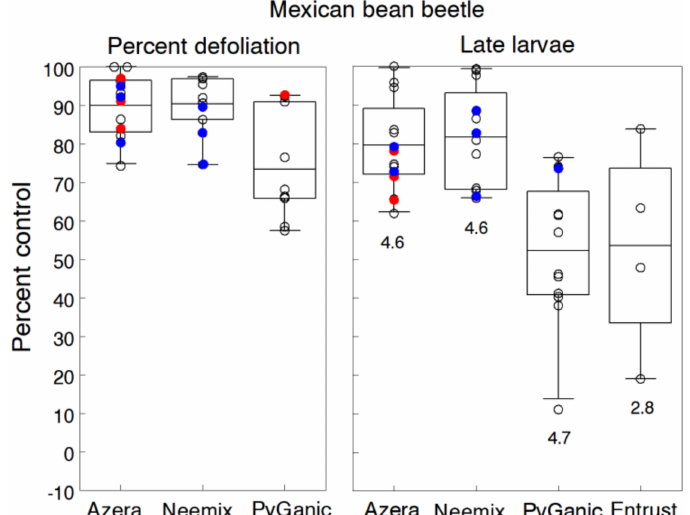
Figure 7. Percent control of Mexican bean beetles with weekly applications of Azera, Neemix, PyGanic and Entrust relative to the untreated control. Mean data are given for percent defoliation and late larvae (3rd and 4th instars) for nine trials on snap beans. Box-whisker plots show the 25% and 75% percentile range of percent control data and the horizontal line in each box is the overall mean control e ffi cacy. Number below each plot indicates the average number of weekly applications. Application rates of Azera, Neemix, PyGanic and Entrust were 2.34 L / h, 1169 mL / h, 2.34 L / h and 71.2 g a.i. / h respectively, except for individual trial data in blue and red indicating lower and higher rates, respectively. There were no significant di ff erences in defoliation among treatments. Azera and Neemix provided significantly higher control of late larvae compared to the other